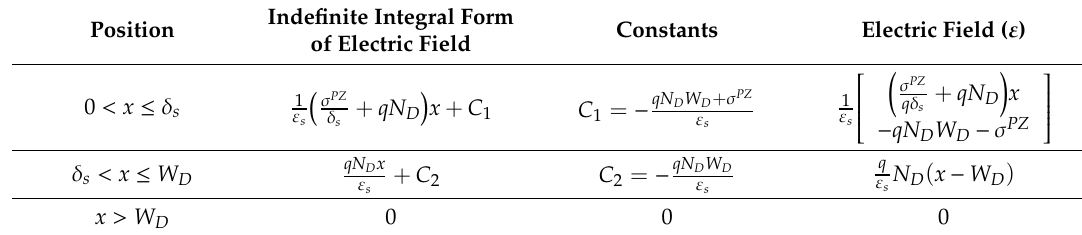
Table A2. Derivations of the electric field distribution of the piezoelectric Schottky interface.